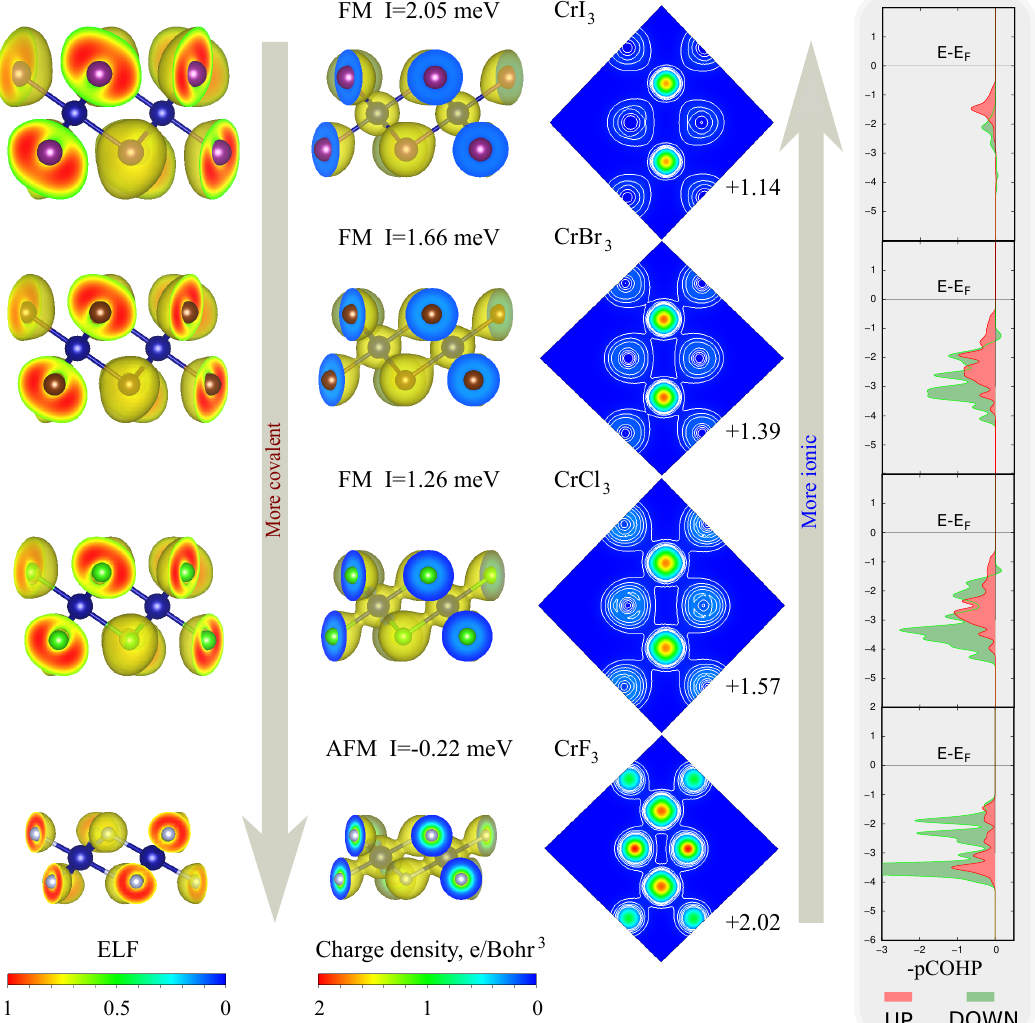
Figure 4. 3D plots are charge density maps and distributions of the electronic localization function in the unit cell of CrX 3 compounds with 0.5 and 0.05 e/Bohr 3 isosurfaces. The 2D cuts are charge density maps in the (Cr-X-Cr) plane with 0.05 e/Bohr 3 isolines (0–0.3 e/Bohr 3 ) where the left and right arrows indicate the ionicity and covalency change correspondently. Numbers near the right and left arrows correspond to the Bader charges of Cr atoms and total magnetic exchange J FM + J AFM . pCOHP graphs for up and down spin channels placed into grey inserts indicate the strength of orbital overlaps for Cr − X bonds where the energy axis is shown relative to the Fermi